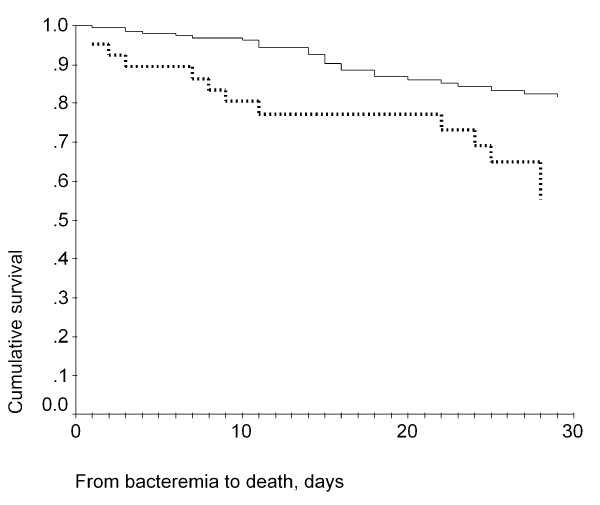
Cox regression survival curves of high-MIC and low-MIC group. Cox regression survival curves of patients with nosocomial MRSA bacteremia who were infected with high-MIC isolates (lower line) or low-MIC isolates (upper line)